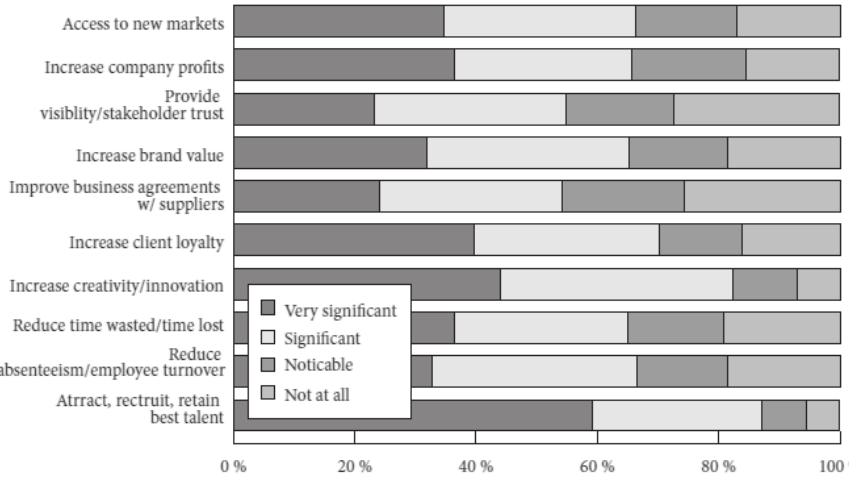
Fig. 2 - SMEs benefits associated with diversity. Source: European Commission,